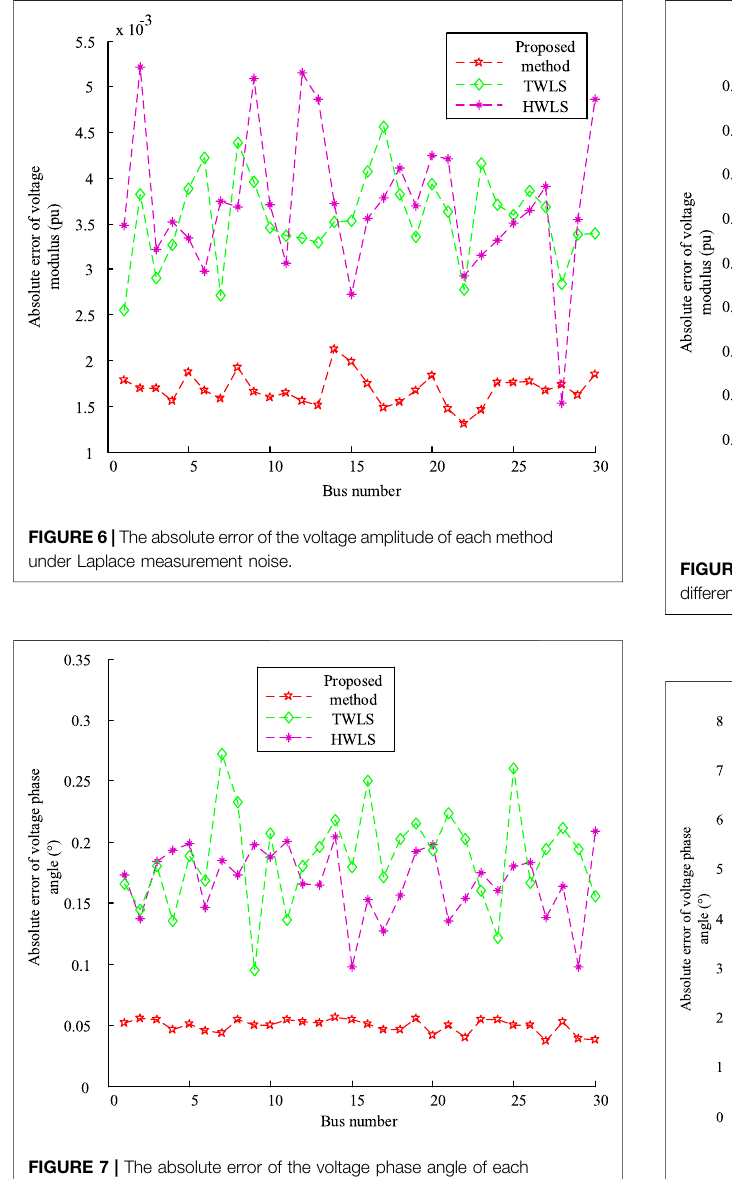
FIGURE 9 | The absolute error of the voltage phase angle different